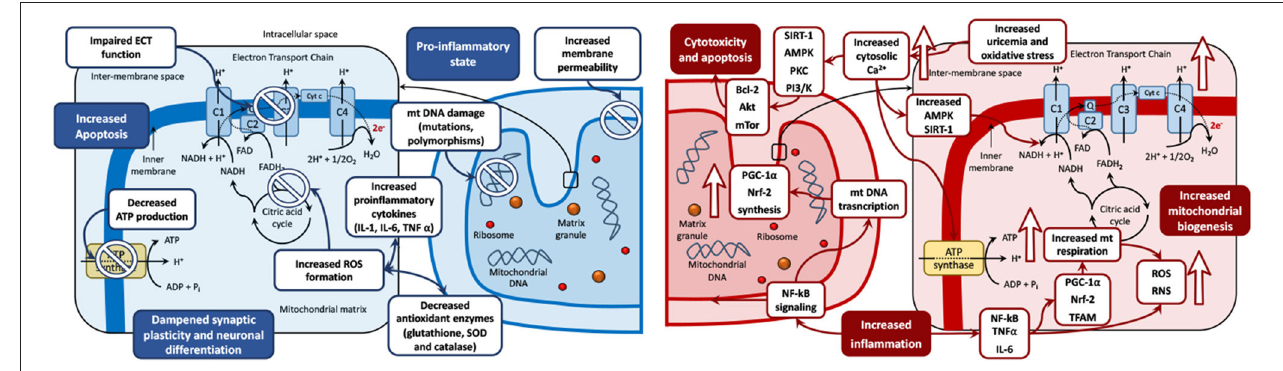
FIGURE 2 | The biphasic mitochondrial model in bipolar disorders. Left: Depression mitochondrial model—Decreased mitochondrial biogenesis. Changes during depressive phases include mitochondrial DNA damage (including mutations and polymorphisms), membrane permeability, and increased formation of ROS. These imbalances lead to a pro-inflammatory state, with increased levels of pro-inflammatory cytokines (IL-1, IL-6 and TNF α ) and decreased antioxidant enzymes (glutathione, SOD and catalase). These disturbances can cause cytotoxicity, increased apoptosis, and dampened synaptic plasticity and neuronal differentiation. Antidepressant drugs have shown the capacity to restore mitochondrial disregulation by reestablishing the oxidant/antioxidant balance and counteract the negative effects of depression on the mitochondria. Right: Mania mitochondrial model—Increased mitochondrial biogenesis. Upward arrows symbolize an increase. Changes during manic phases include increased inflammation and elevated production of ROS and RNS, driven by increased activity of the NF-kB signaling pathway. NF-kB signaling stimulates mitochondrial biogenesis via the upregulation of PGC-1 α , Nrf-2, and TFAM. PGC-1 α and Nrf-2 stimulate mitochondrial respiration, which is a further source of oxidative stress via ROS and RNS production. Increased oxidative stress could induce an increase in the levels of cytosolic Ca 2 + ions seen in mania compared to other phases of the disease. Elevated Ca 2 + levels can stimulate oxidative phosphorylation and ATP production and may lead to the activation of AMPK and SIRT1, which may increase the activity of NAD + . In an environment of increasing oxidative stress, the activity of SIRT1, AMPK, PKC PI3/K are increased. This can foster mitochondrial survival leading to cytotoxicity and cell death via activation of proapoptotic pathway cascades (Bcl-2, Akt and mTor among others). Increased uric acid levels increase the uptake of Ca 2 + ions by mitochondria, increase the mitochondrial membrane potential and therefore enhance ATP production. Antimanic drugs including mood stabilizers and antipsychotics may restore mitochondrial dysregulation by counteracting the mitochondrial imbalance leading to neurogenesis, neuroplasticity, and cell survival. ADP, adenosine diphosphate; ATP, adenosine triphosphate; BDNF, brain-derived neurotrophic factor; C, complex; Cyt c, cytochrome c; e-, electron; ECT, electron transport chain; FAD, flavin adenine dinucleotide; IL, Interleukin; Q, coenzyme Q; mt DNA, mitochondrial DNA; mTOR, mechanistic target of rapamycin; NAD, nicotinamide adenine dinucleotide; NF, nuclear factor; Pi, inorganic phosphate; PI3/K, Inositol 1,4,5 triphosphate; PKC, Protein Kinase C; ROS, reactive oxygen species; RNS, reactive nitrogen species; TFAM, mitochondrial transcription factor A; TNF α , tumor necrosis